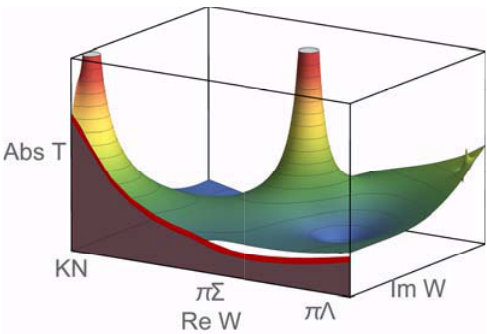
Figure 2. Modulus of the analytic continuation of the J P = 1 / 2 − π N scattering amplitude into the complex s -plane. Shown is √ s = the (- - - + + + ) Riemann sheet. The two poles at √ s = (1 . 69 − i 0 . 05) GeV, correspond- (1 . 51 − i 0 . 14) GeV and ing to the S 11 (1535) and the S 11 (1650), respectively, are clearly visible. The stars and black dots refer to other determinations as listed in [3]. For the definitions of the sheets, see e.g. Ref. [5].